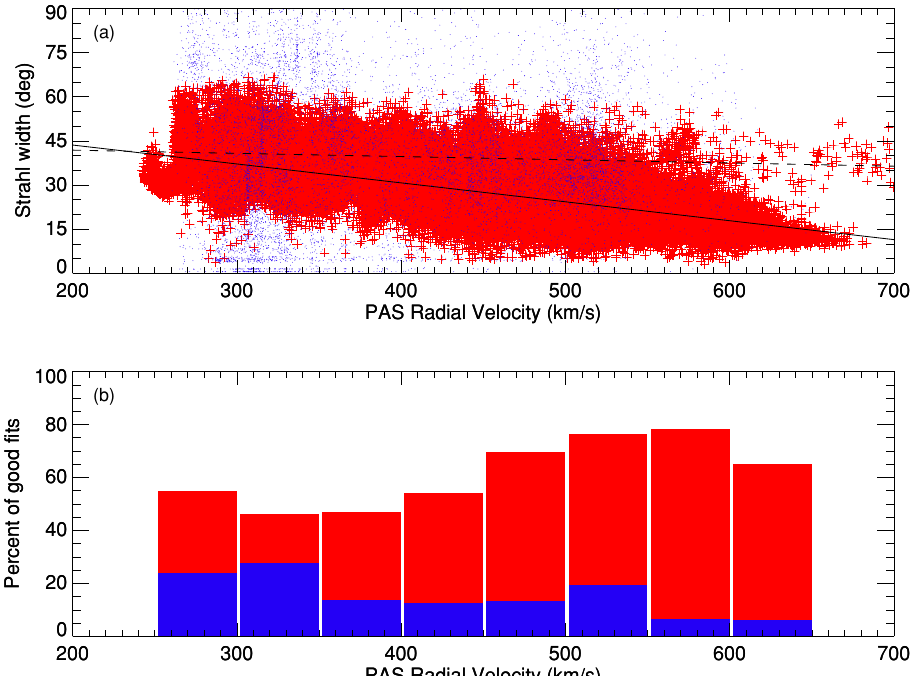
Figure 4. Characteristics and occurrence rates for anti-sunward strahl beams and sunward deficits as a function of background solar wind flow speed measured by EAS-PAS. The format is the same as for Figure 3, but the horizontal axis in each panel now shows the radial flow speed observed during each sample. ( a ) Scatter plots of the pitch angle width of the strahl (red points) and deficits (blue points) as a function of solar wind flow speed; ( b ) Occurrence rate histograms, in 50 km s − 1 wide bins bins, for the strahl (red) and deficit (blue) samples. The data is plotted as a percentage of the total number of good fits to samples taken in the relevant flow speed bins. Note that the height of the blue bars has been increased by a factor of 3 to aid